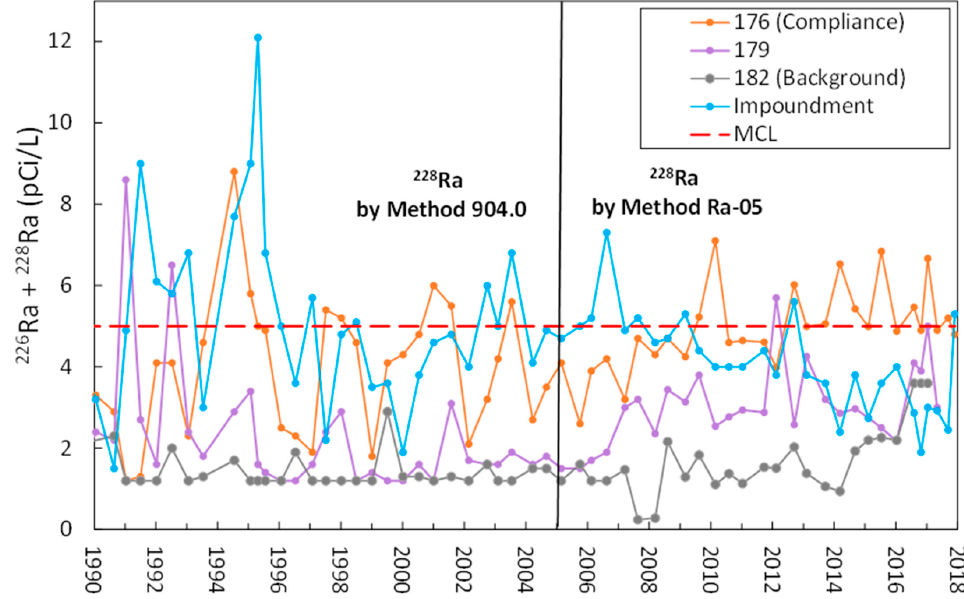
Figure 1. 226 Ra + 228 Ra concentrations in Site monitoring wells and the Impoundment.